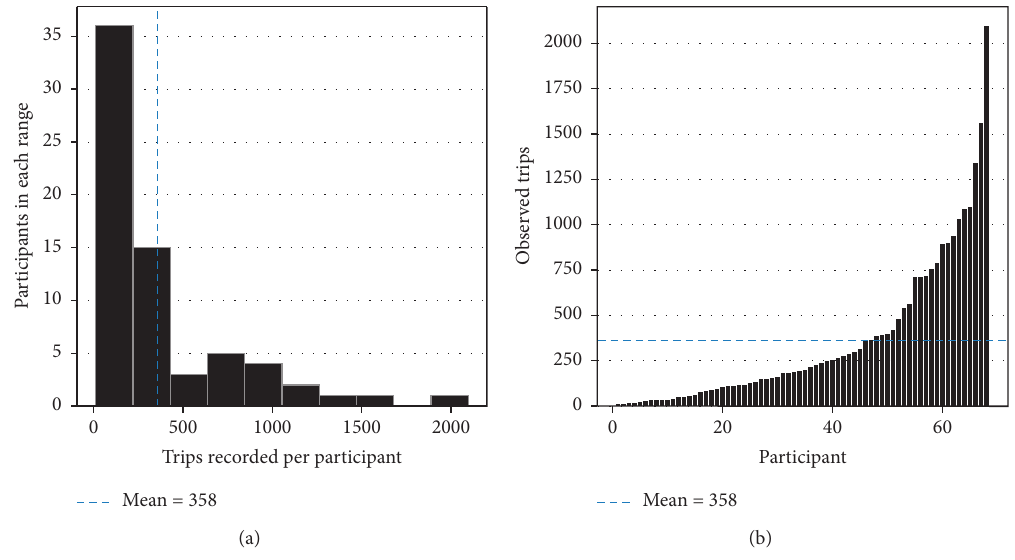
Figure 18: Distribution and share of trips recorded by active